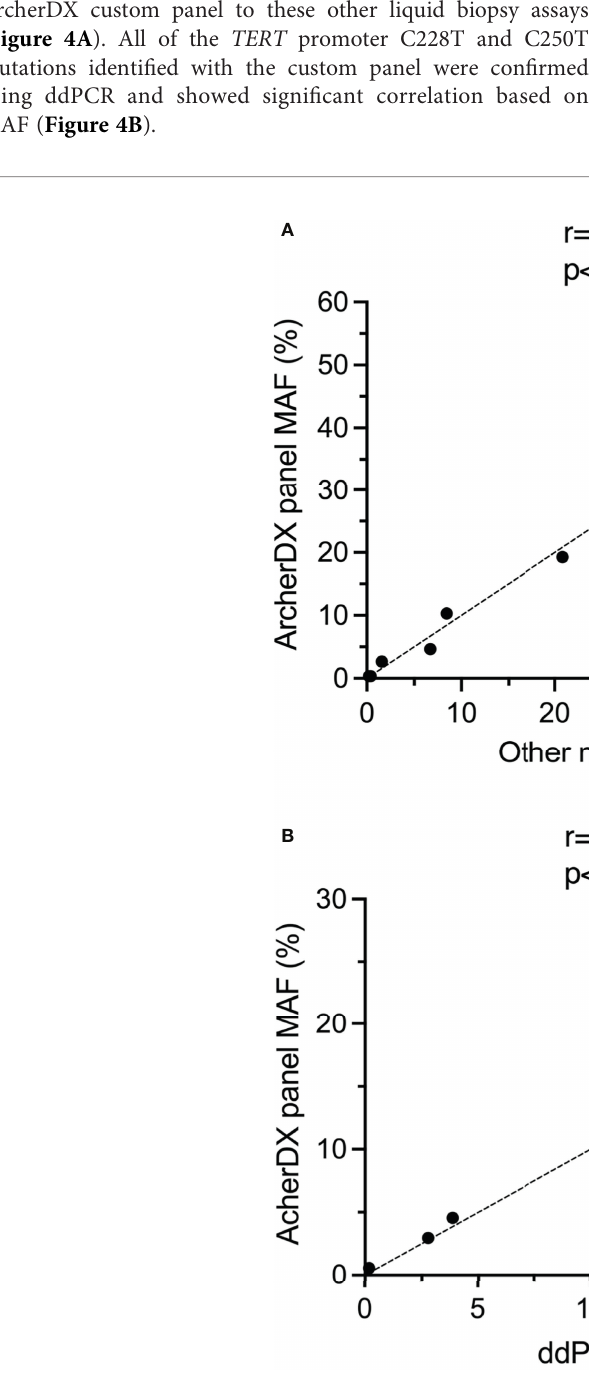
FIGURE 4 | Validation of the ArcherDX custom melanoma ctDNA panel. (A) Correlation of driver mutant allele frequency (MAF) determined by the ArcherDX custom melanoma ctDNA panel versus other liquid biopsy analysis [ddPCR or Thermo fi sher custom melanoma ctDNA panel (25)]. (B) Correlation of TERT promoter MAF determined by the ArcherDX custom melanoma ctDNA panel versus ddPCR. For ddPCR data see Table S3 . Pearson correlation coef fi cient analysis was